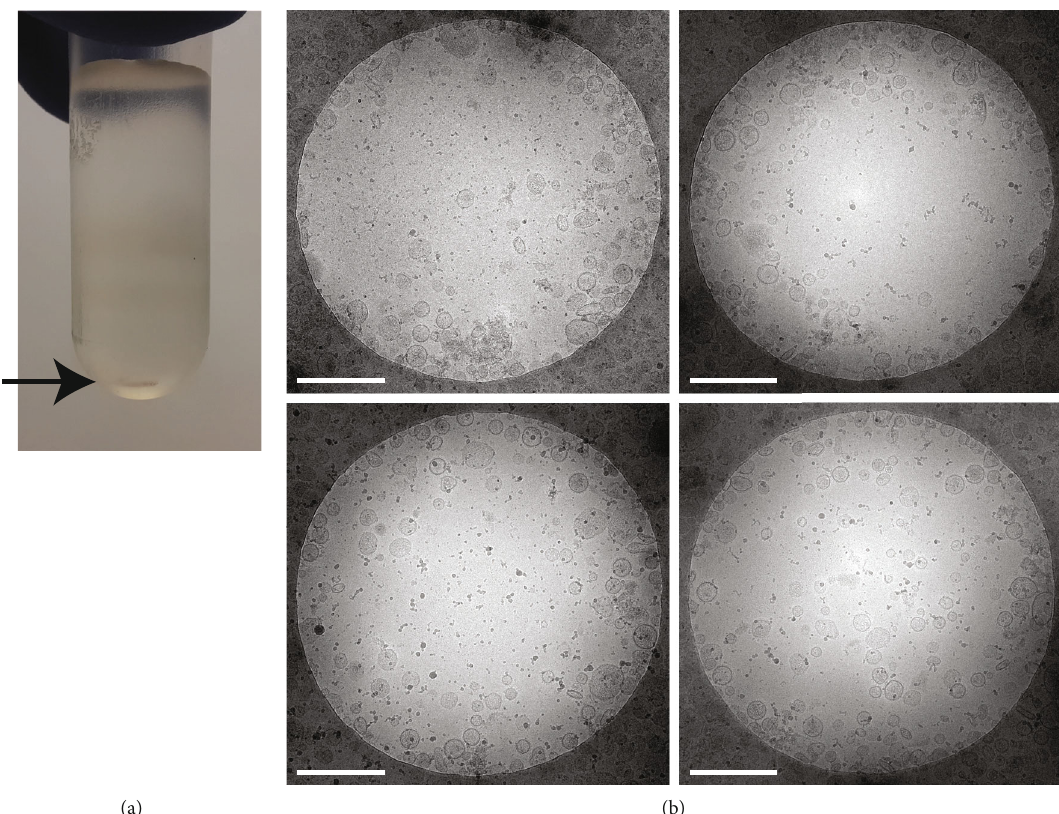
Figure 4: Small iodixanol gradient separates adult worm EVs from non-EV contaminants. Adult worm EV-enriched UC pellets were overlaid with a small (1.7 ml) iodixanol density gradient and centrifuged for two hours. (a) The gradient after centrifugation shows hemozoin (black arrow) in the bottom of the tube. (b) Cryo-EM analysis of washed iodixanol gradient fractions with density 1.07-1.21g/ ml shows that EV-enriched fractions of the small gradients are devoid of hemozoin crystals. Scale bars are